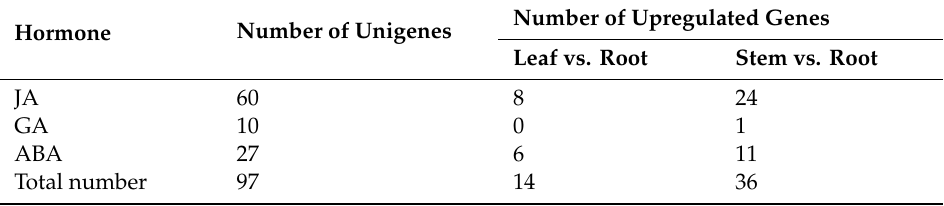
Table 3. Classification and number of hormone identified in the DEGs database for C. chinense.